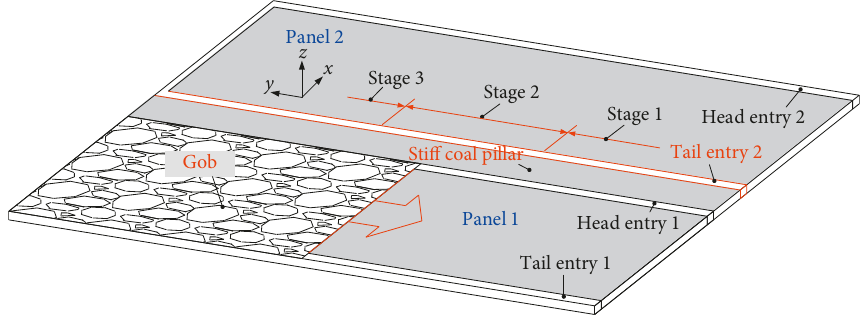
Figure 1: Layout of two-entry system in longwall